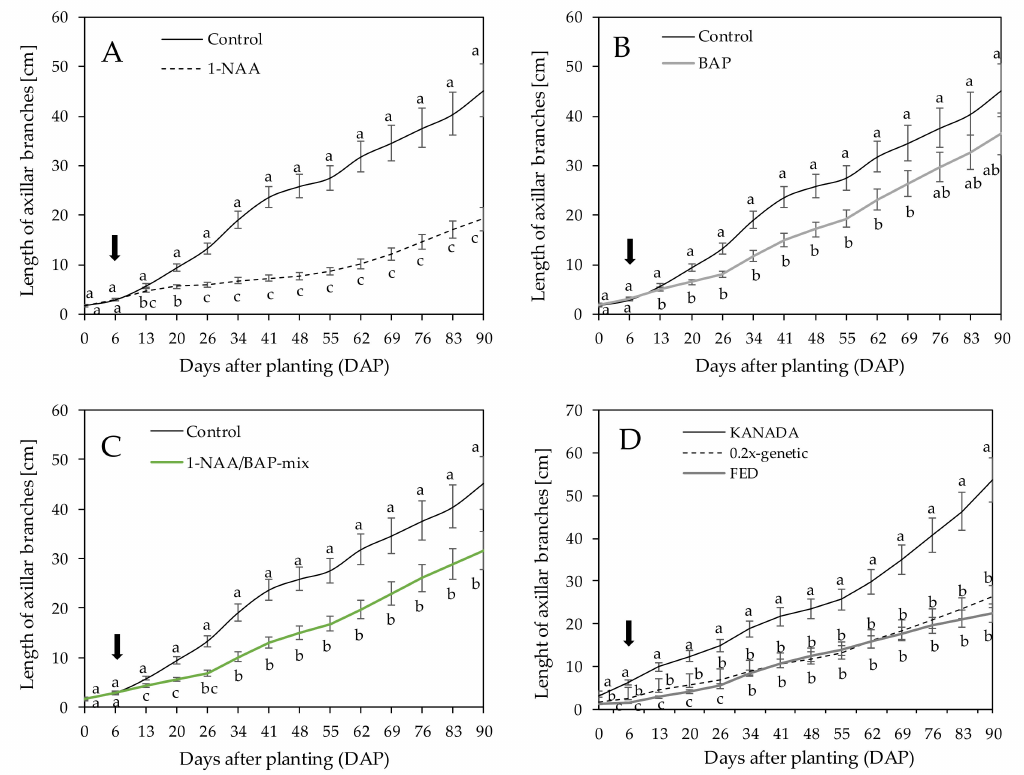
Figure 3. Median length of axillar branches in cm over all three tested genotypes treated with ( A ) NAA, ( B ) BAP, and ( C ) NAA / BAP-mix compared to the nontreated control each over a time period of 90 days. ( D ) Mean length of axillar branches of genotype KANADA and 0.2x-genetic across time. Means covered with at least one identical lowercase letter did not di ff er significantly at α = 0.05. The arrow shows the time point (6 DAP) of the first